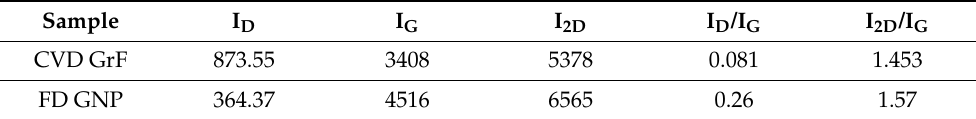
Table 1. The intensity of D, G, and 2D peak for FD GNP and CVD GrF foams.